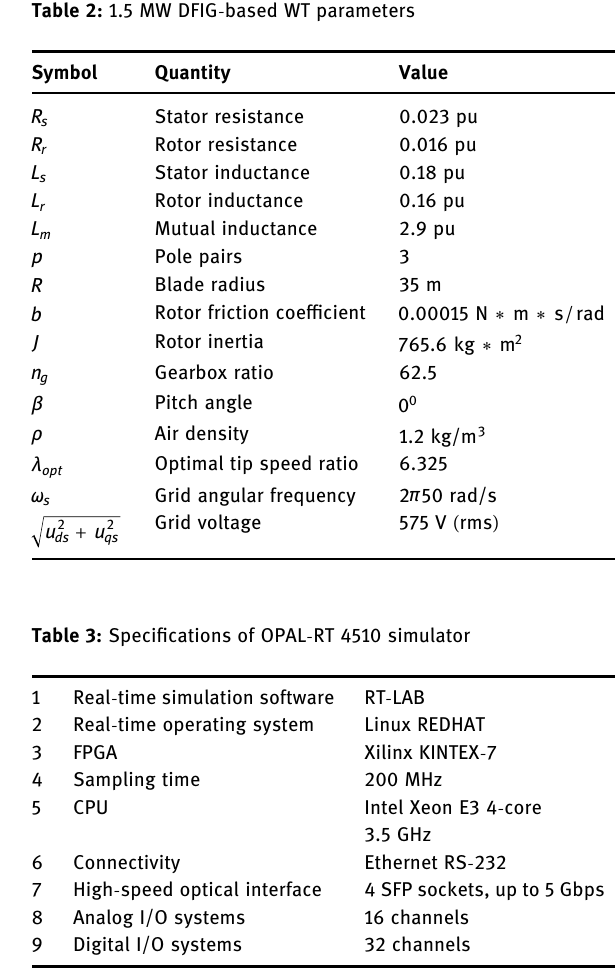
Figure 8: HIL setup in OPAL - RT 4510 simulator.